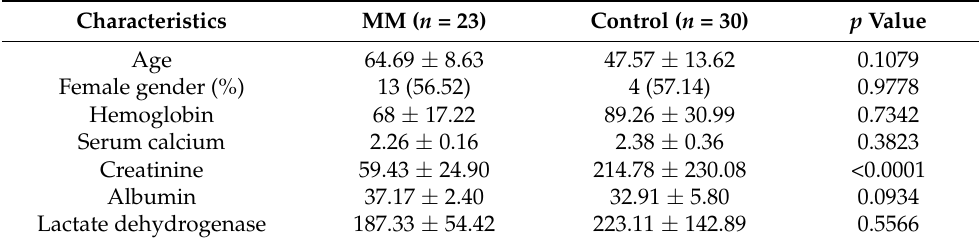
Table 1. Characteristics of the